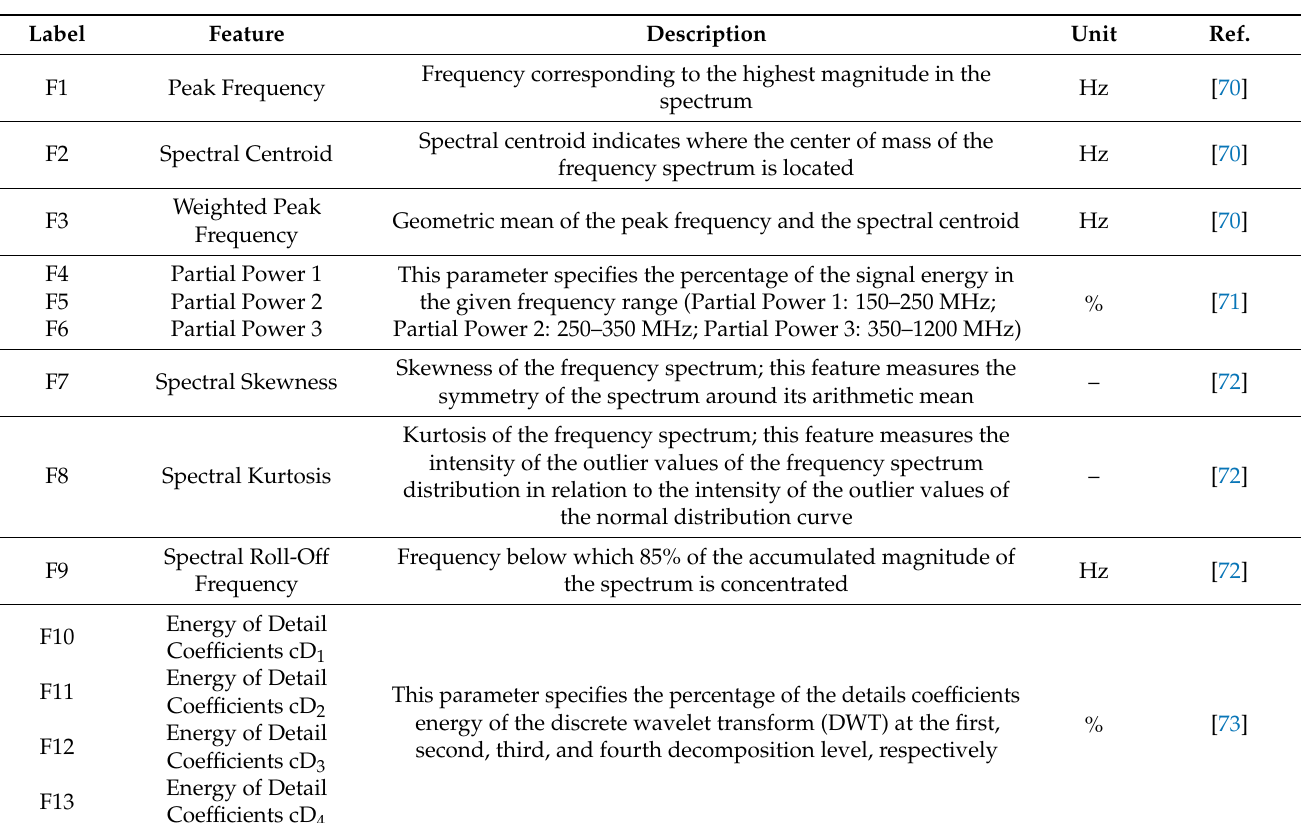
Table 3. List and description of selected